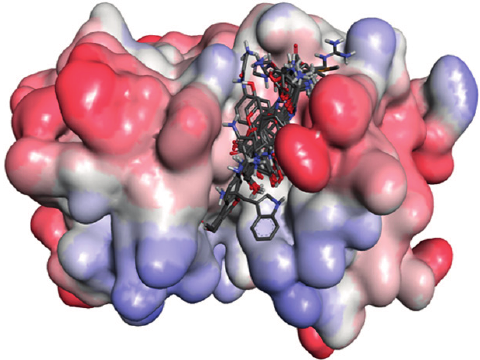
Figure 6. The protein contact potential of zmCP1–ligands complex. Red color represents negative charge; blue represents positive charge; and grey color represents neutral